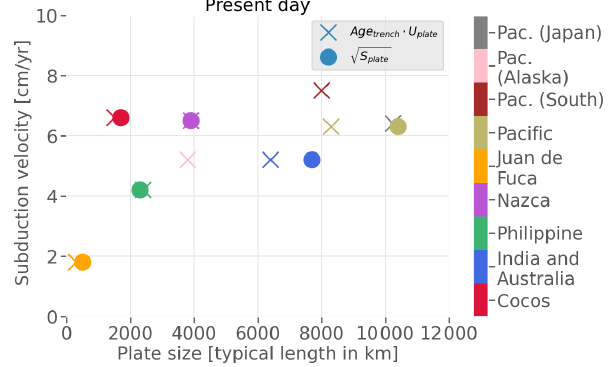
Figure 1. Present-day subducting plate velocities, measured at the trench in a lower-mantle (plume) reference frame (O’Neill et al., 2005), as a function of plate size, in terms of a typical plate length. Typical plate length is a measure of plate size calculated as the age at the trench (Age trench ) multiplied by plate velocity ( U plate ) (x markers) or as the square root of the plate surface area ( S plate , cir- cles). Velocity data from Sdrolias and Müller (2006) and Schellart et al. (2007) and plate size data from Conrad and Hager